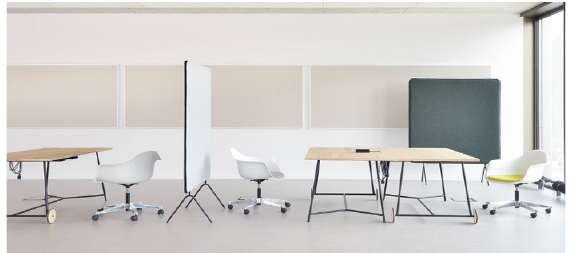
Fig. 5. Final furniture concept: tables and pinboards